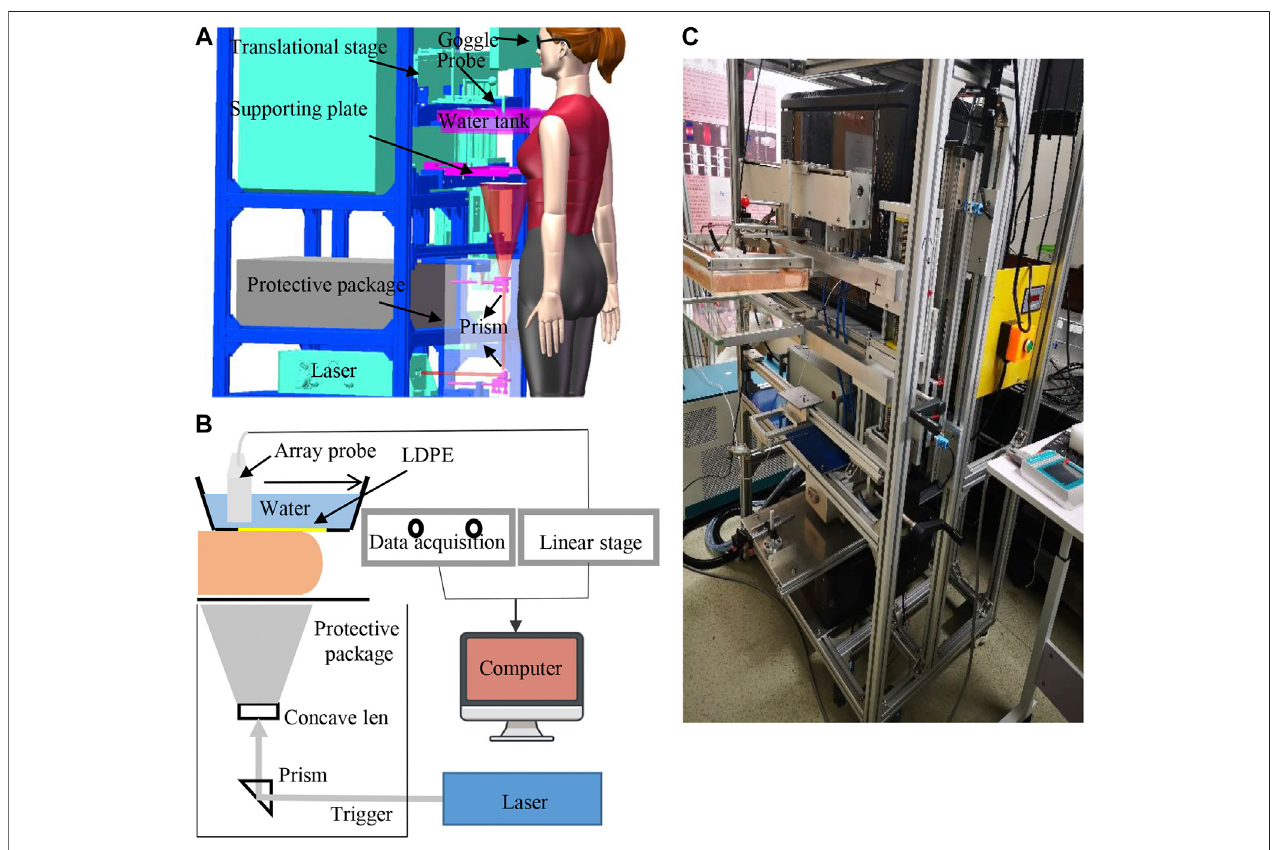
FIGURE 1 | System setup. (A) 3D interior structure presentation of the photoacoustic breast imaging system; (B) schematic diagram of the system design. (C) Photography of the prototype system.